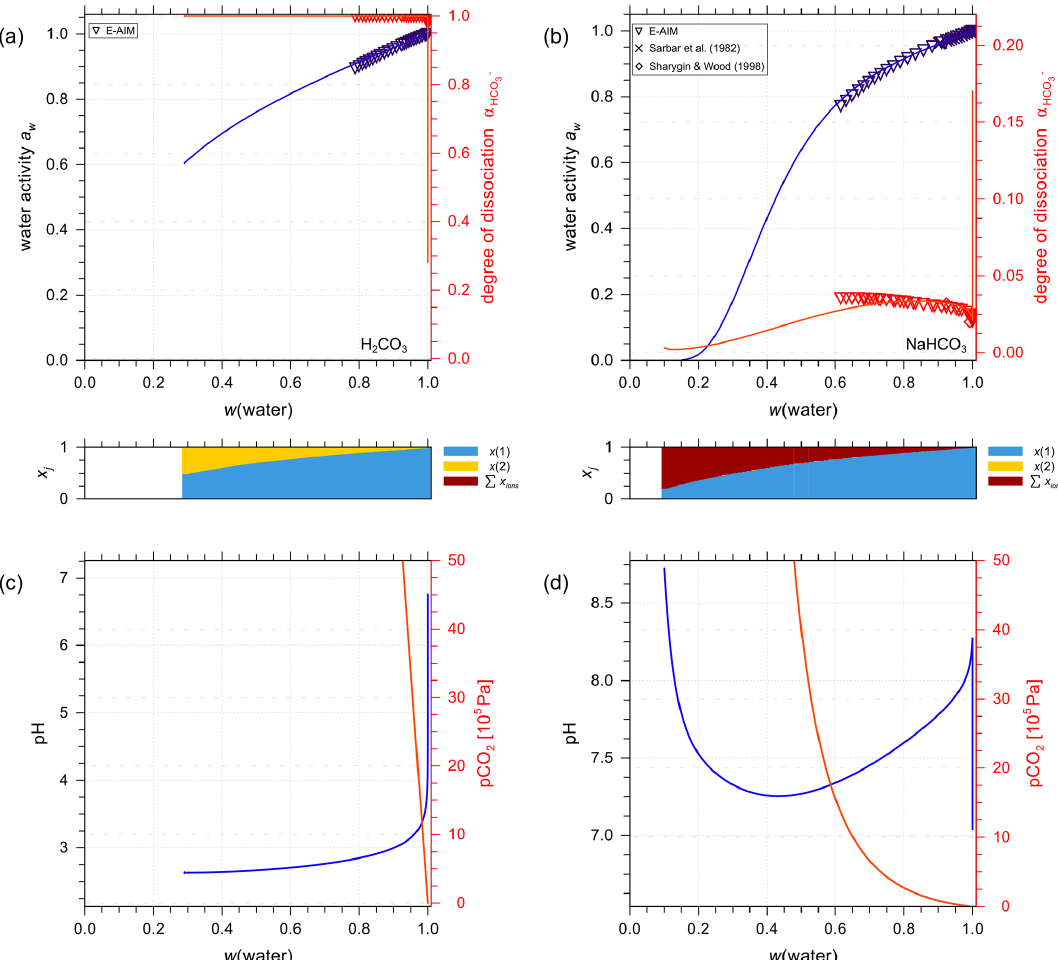
− in 3 + CO 2 − + OH − ) and (b) NaHCO + 3 (mixture species: water 3 3 2(g) in (c) H 2 CO 3 and (d) NaHCO 3